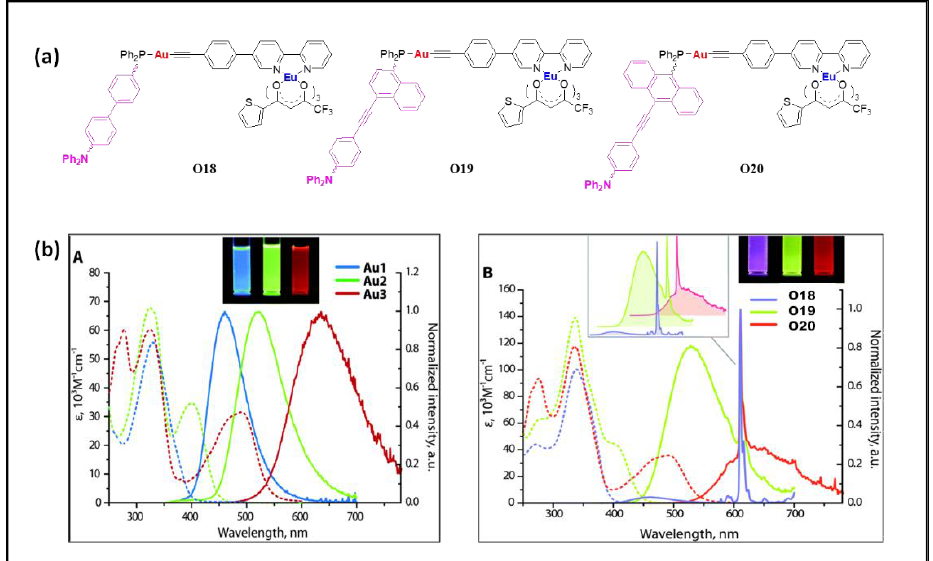
Figure 12. ( a ) Bipyridine-based Au(I) complexes incorporating Eu(III) β -diketonate fragment. ( b ) UV-vis absorption (dashed lines) and normalized emission (solid lines) spectra of metallo-ligands Au1 – Au3 (A), and dyads O18 – O20 (B) the photographs show the corresponding solutions under UV cial 3.0 Unported License.